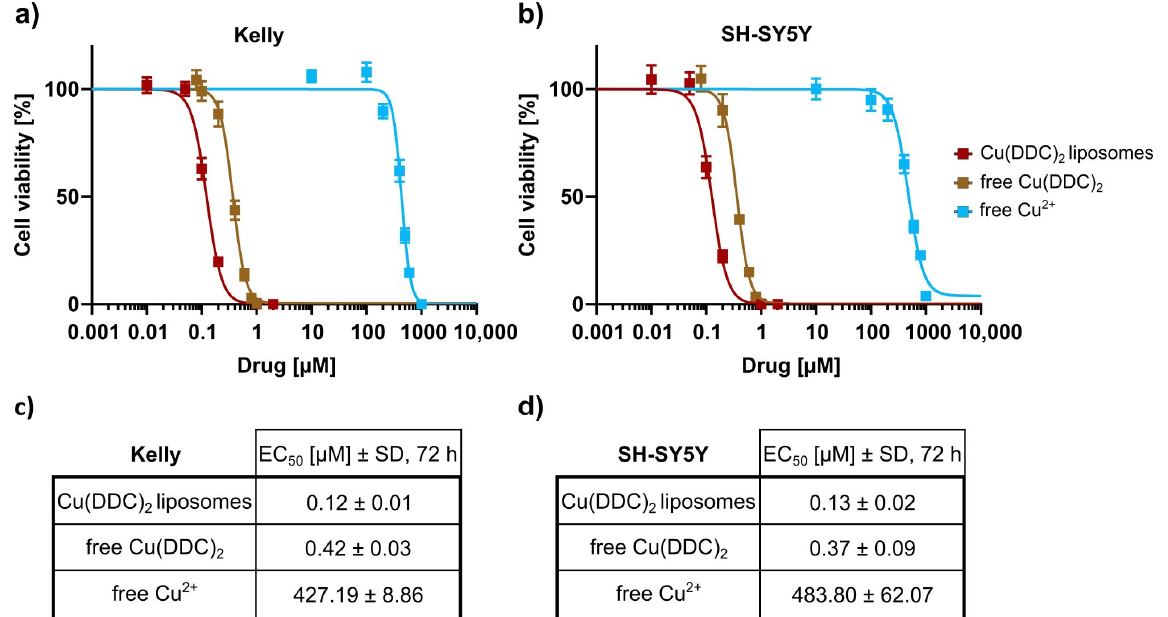
Figure 5. Determination of the cell viability reduction of Cu(DDC) 2 liposomes and the free substances Cu(DDC) 2 and Cu 2+ on 2D monoculture neuroblastoma cell models. ( a , b ) 2D Kelly ( a ) and SH-SY5Y ( b ) monolayers were treated with liposomal Cu(DDC) 2 (DSPC:Chol [55:45 molar ratio]), free Cu(DDC) 2 and free Cu 2+ . Cell viability curves were obtained using 2D CellTiter-Glo ® assay after 72 h of treatment. Data are expressed as the mean ± SD ( n = 3–4). ( c , d ) EC 50 values after 72 h of treatment with liposomal Cu(DDC) 2 , free Cu(DDC) 2 , and free Cu 2+ . Data are expressed as the mean ± SD ( n = 3–4).